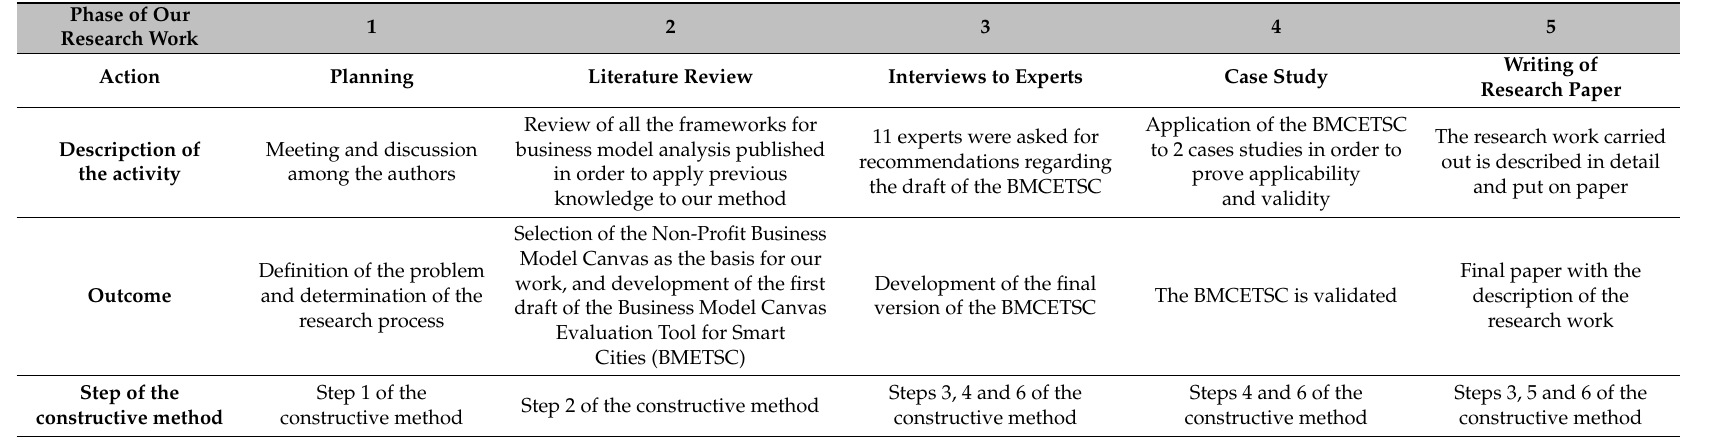
Table 1. Research work